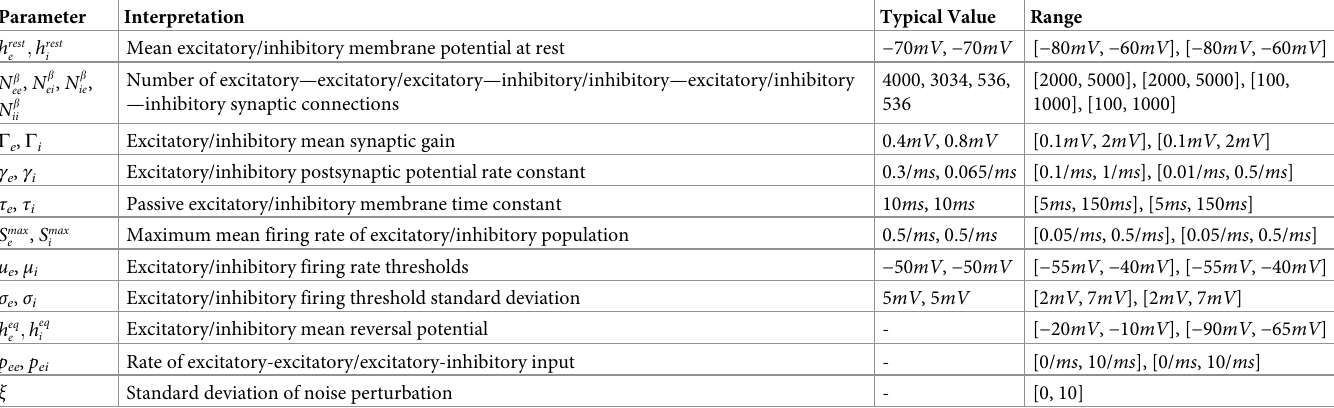
Table 1. Parameter values with physiological interpretation, a typical chosen value and typically used bounds [16,